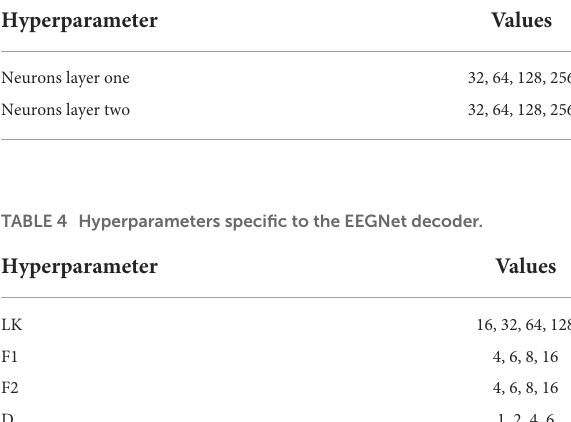
TABLE 2 Common hyperparameters of both models. TABLE 3 Hyperparameters specific to the LSTM decoder.